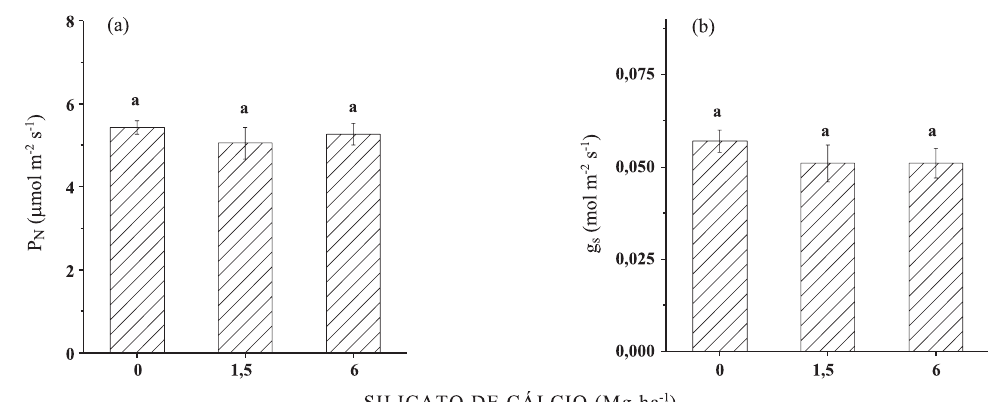
Figura 4. Assimilação de CO (P , em a) e condutância estomática (g , em b) de cafeeiros submetidos à 2 N S adubação silicatada. Condições de medida: radiação fotossinteticamente ativa de 1.000 μμ μμ μ mol m -2 s -1 , temperatura foliar de 24,5±2,0 ºC e diferença de pressão de vapor entre folha e ar de 1,6±0,6 kPa. Cada histograma representa o valor médio de 18 repetições (± erro-padrão). Letras iguais entre tratamentos indicam semelhança estatística pelo teste de Tukey (p >